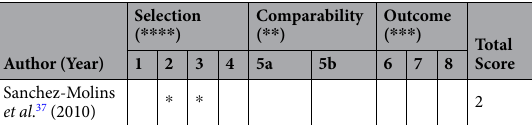
Table 4. Quality of the studies on the Newcastle-Ottawa Quality Assessment Scale for case-control studies. Criteria: (1) Adequate case definition. (2) Representativeness of the cases. (3) Selection of controls. (4) Definition of controls. (5) Comparability of cases and controls on the basis of the design or analysis, (5a) for one factor and (5b) for additional factor. (6) Ascertainment of exposure. (7) Same method of ascertainment for cases and controls. (8) Non-response